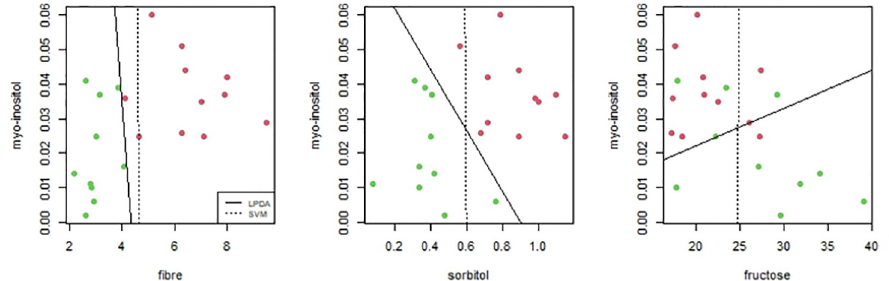
Fig 4. Examples where LPDA gets less separation errors than SVM .